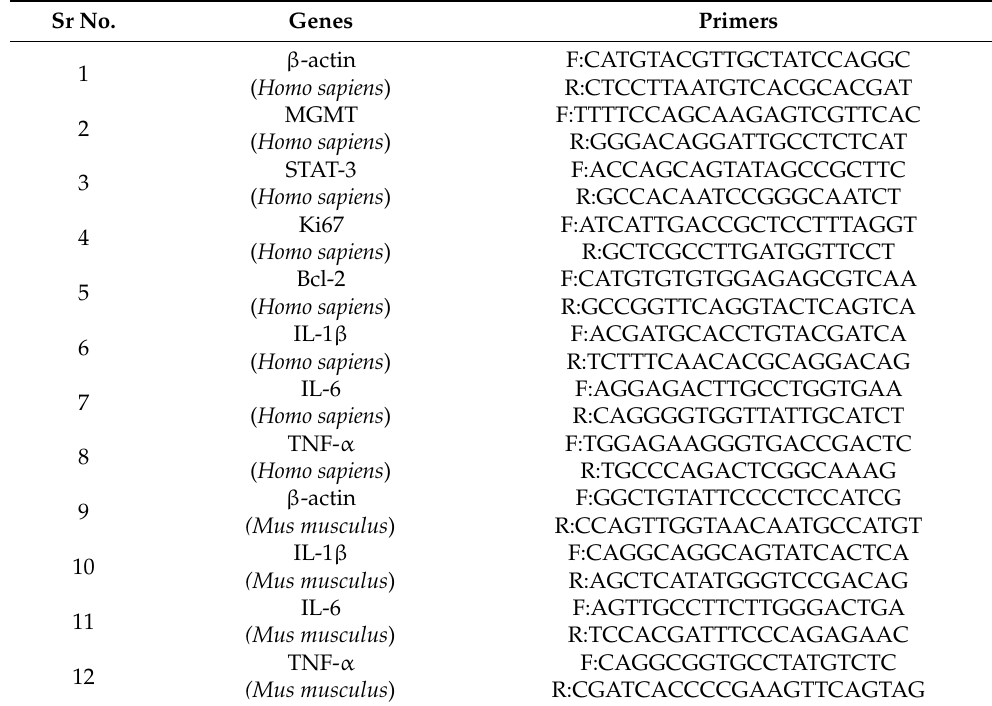
Table 2. Primer Sequences designed for